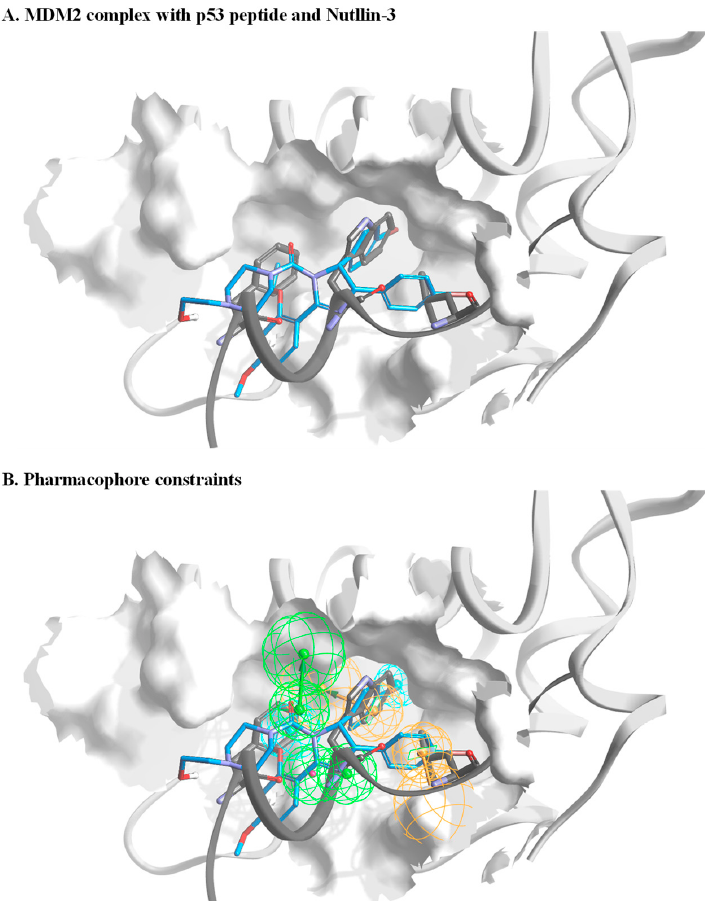
Figure 1. Setting pharmacophore constraints. ( A ) A general overview of MDM2 in a complex with p53 peptide (dark grey) and Nutlin-3 (blue). The structures are based on PDBs, 3DAB, 4DIJ, 3LNZ, 1YCR, and 1RV1. The peptide backbone is shown with only side chains of the p53 peptide that are in direct interaction with MDM2. ( B ) An illustration of pharmacophore constraints that were defined based on analysis of the MDM2 structures. The green spheres represent the location and orientation of potential acceptors within the bound ligand, orange spheres represent the location and direction of the aromatic system, and cyan represents the location of a hydrophobic part.